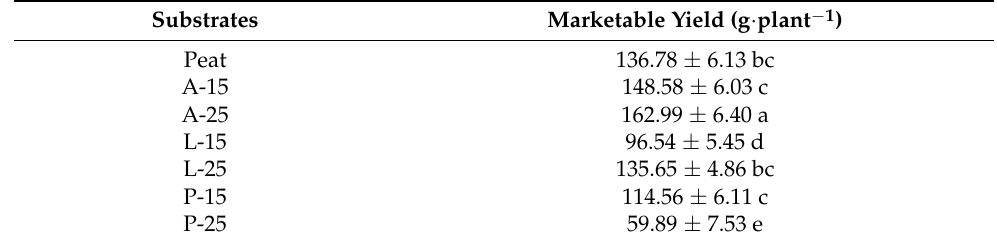
Figure 1. Total cumulative yield (g · plant − 1 ) of strawberry cv. ‘Honeoye’ in different substrates. * Means followed by the same letters are not significantly different at p < 0.05 according to Tukey’s HSD ( n = 5). A-15—A-SMS:Peat (15:85%), A-25—A-SMS:Peat (25:75%), L-15—L-SMS:Peat (15:85%), L-25—L-SMS:Peat (25:75%), P-15—P-SMS:Peat (15:85%) and P-25—P-SMS:Peat (25:75%). Table 7. Cumulative marketable yield of strawberry cv. ‘Honeoye’ cultivated in different substrates (mean ± SD).